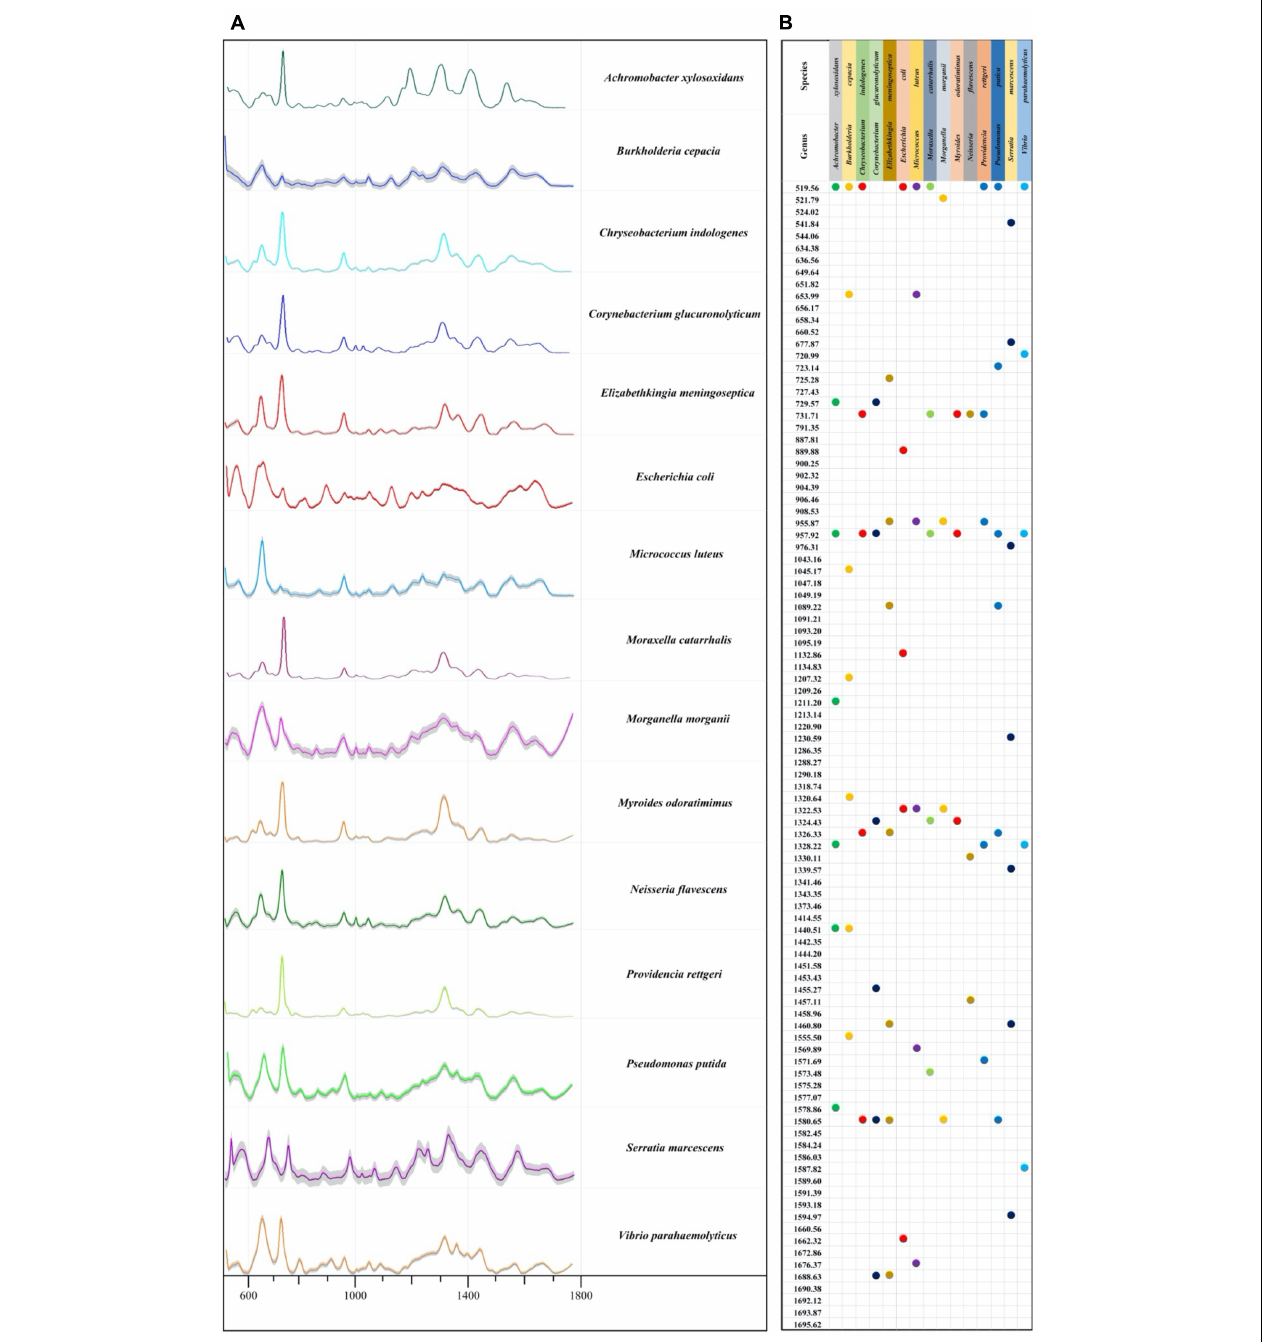
FIGURE 2 | Average Raman spectra and the corresponding characteristic peaks of 15 bacterial pathogens isolated from clinical samples. (A) Average surfaced enhanced Raman spectra (SERS) spectra of 15 different clinical bacterial pathogens. Shaded part in each spectrum was 20% error band. (B) Dot plot distribution of characteristic peaks in the Raman spectra for 15 bacterial